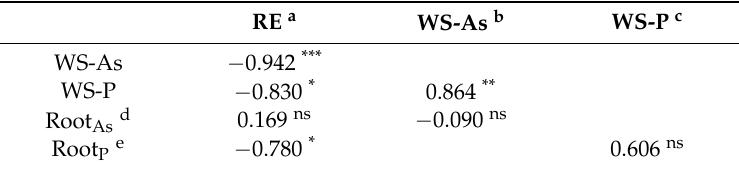
Table 4. Correlation coefficients ( r ) among the experimental results ( n =